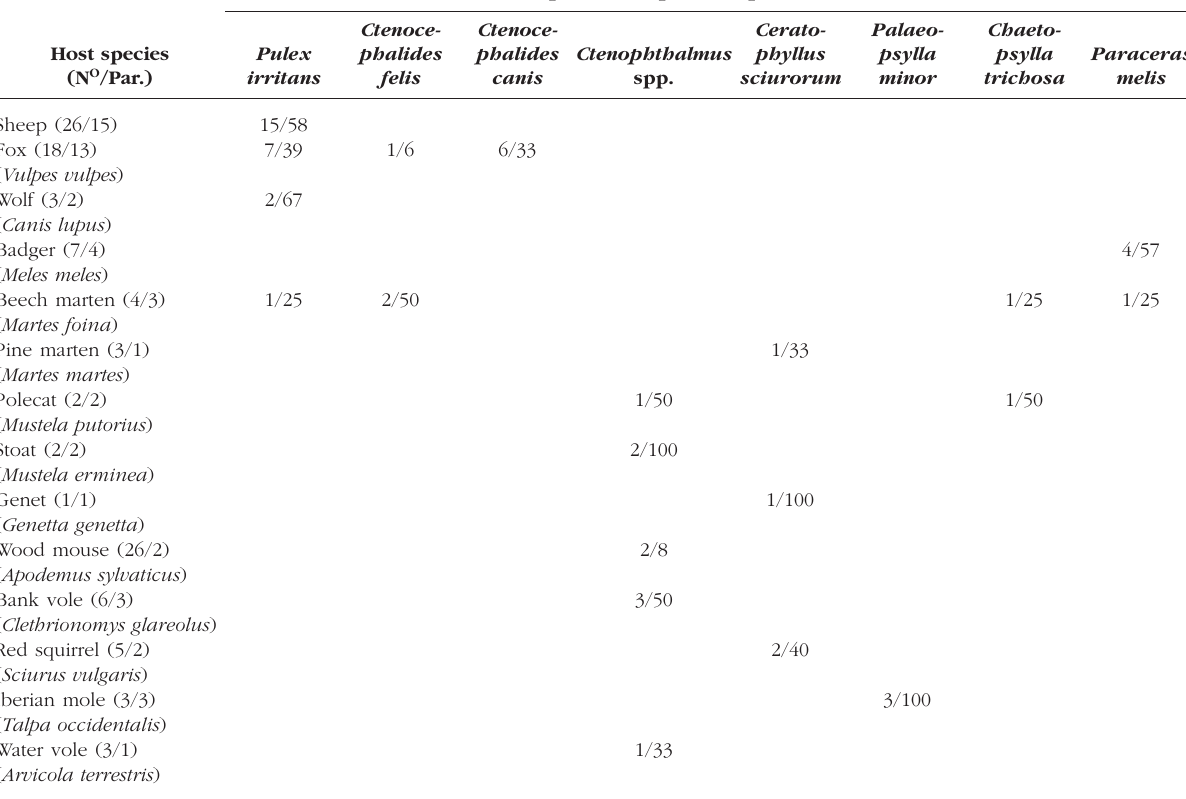
Table II b. – Species of fleas identified on the host animals.